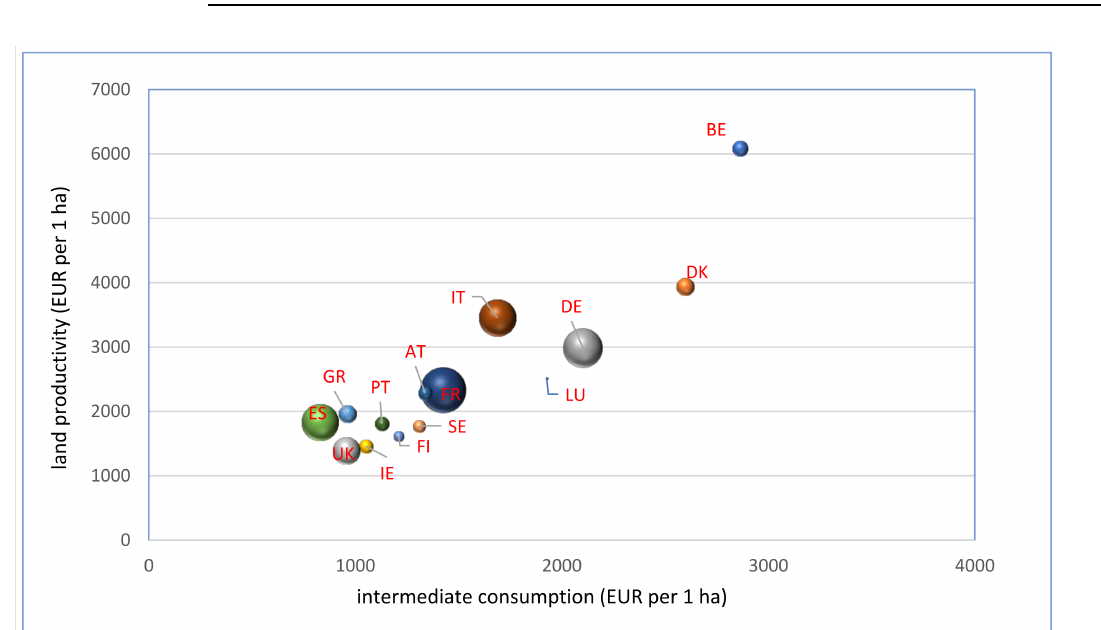
Figure 5. Position of countries forming the EU-15 depending on land productivity, intermediate consumption per 1 ha, and share in the value of agricultural production of the EU from 2010 to 2019. Abbreviations denoting EU-15 countries: Belgium, BE; Denmark, DK; Germany, DE; Ireland, IE; Greece, GR; Spain, ES; France, FR; Italy, IT; Luxembourg, LU; Netherlands, NL; Austria, AT; Portugal, PT; Finland, FI; Sweden, SE; United Kingdom, UK. Note: The size of the balls refers to the percentage of the EU’s agricultural